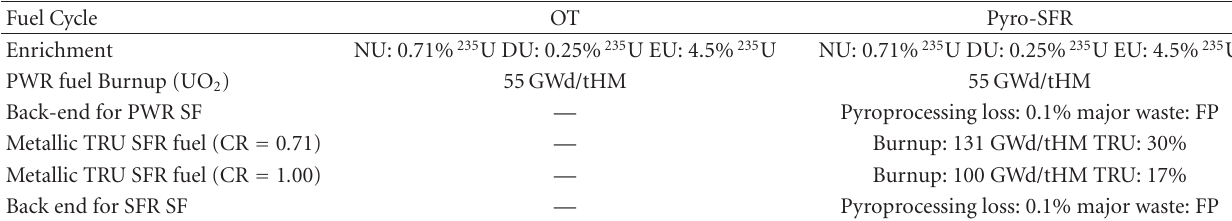
Table 2: Parameters of fuel cycle